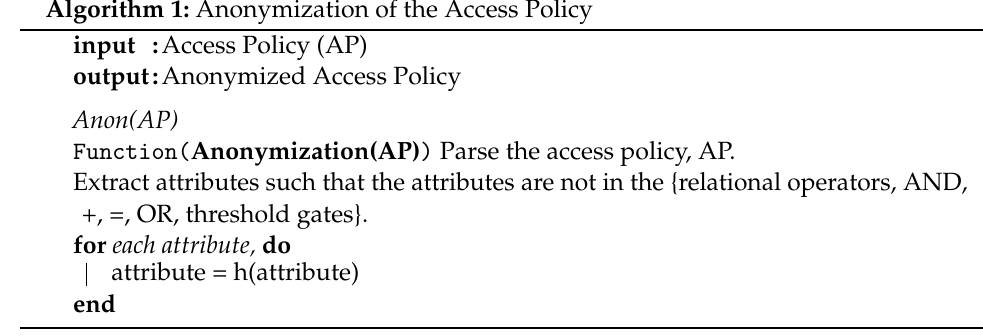
Algorithm 1: Anonymization of the Access